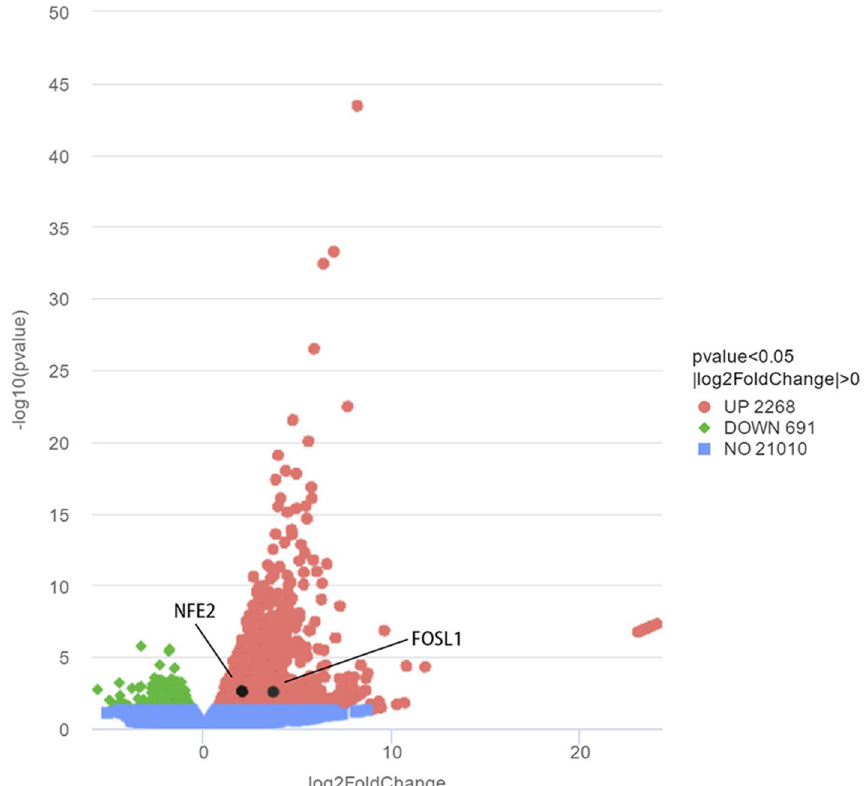
Fig. 3 Comparison of 3 probands in Family 1 and 3 subjects from nonfamilial TN subject group. We performed RNA-seq to identify differential gene expression between the blood samples of 3 probands in Family 1 and 3 subjects from the nonfamilial TN subject group. A total of 2268 genes were upregulated (log Fold Change > 0; p value < 0.05) and 691 genes were downregulated (log Fold Change < 0; p value <